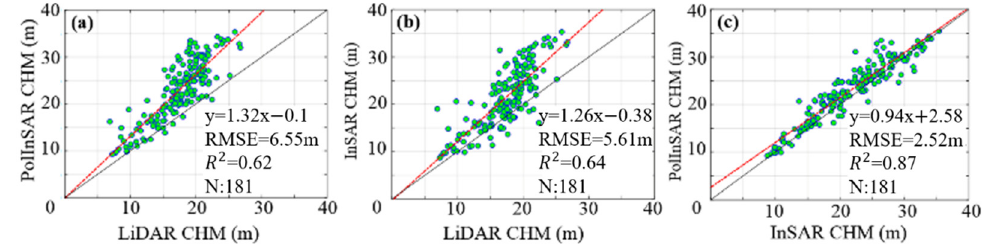
Figure 9. Comparison of the forest CHM results: ( a ) PolInSAR RVoG-derived CHM vs. LiDAR-derived CHM; ( b ) InSAR TF-RVoG-derived CHM vs. LiDAR-derived CHM; ( c ) PolInSAR RVoG-derived CHM vs. InSAR TF-RVoG-derived CHM.